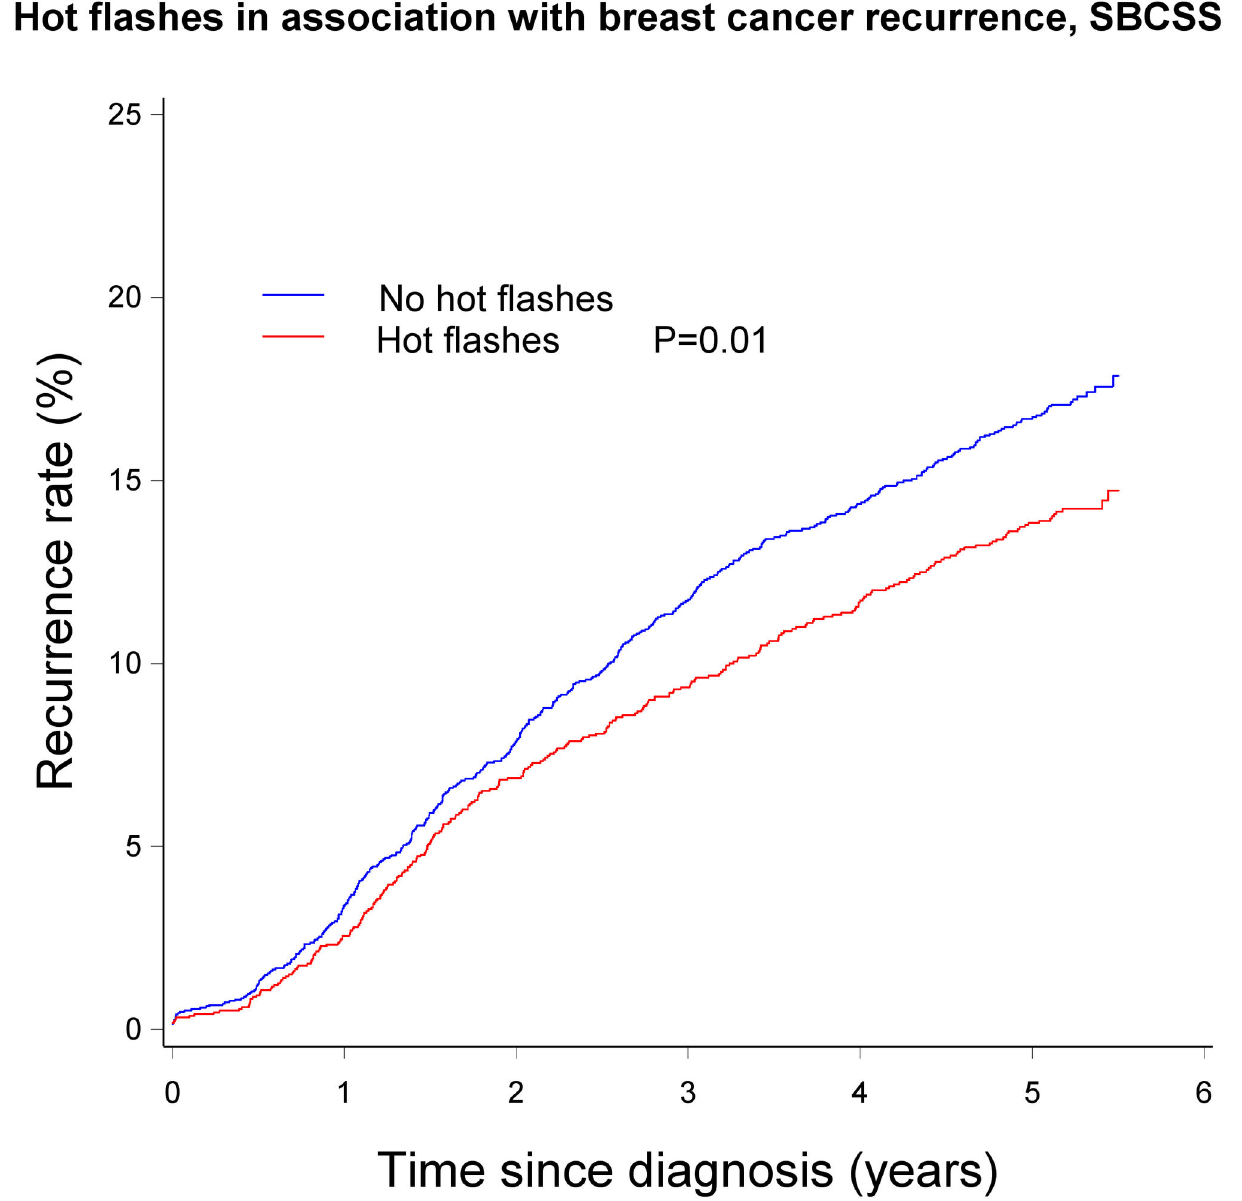
Figure 1. Hot flashes in association with breast cancer recurrence,